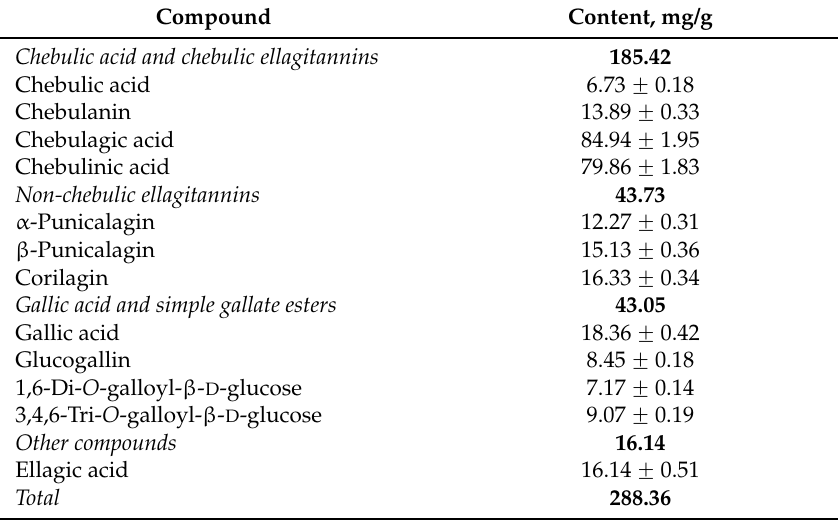
Table 1. Phenolic content in Padma Hepaten plant mixture ( ˘